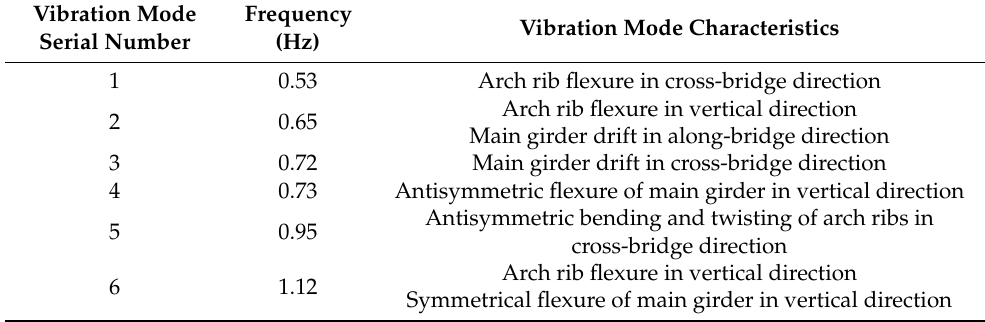
Table 8. Calculation results of self-vibration